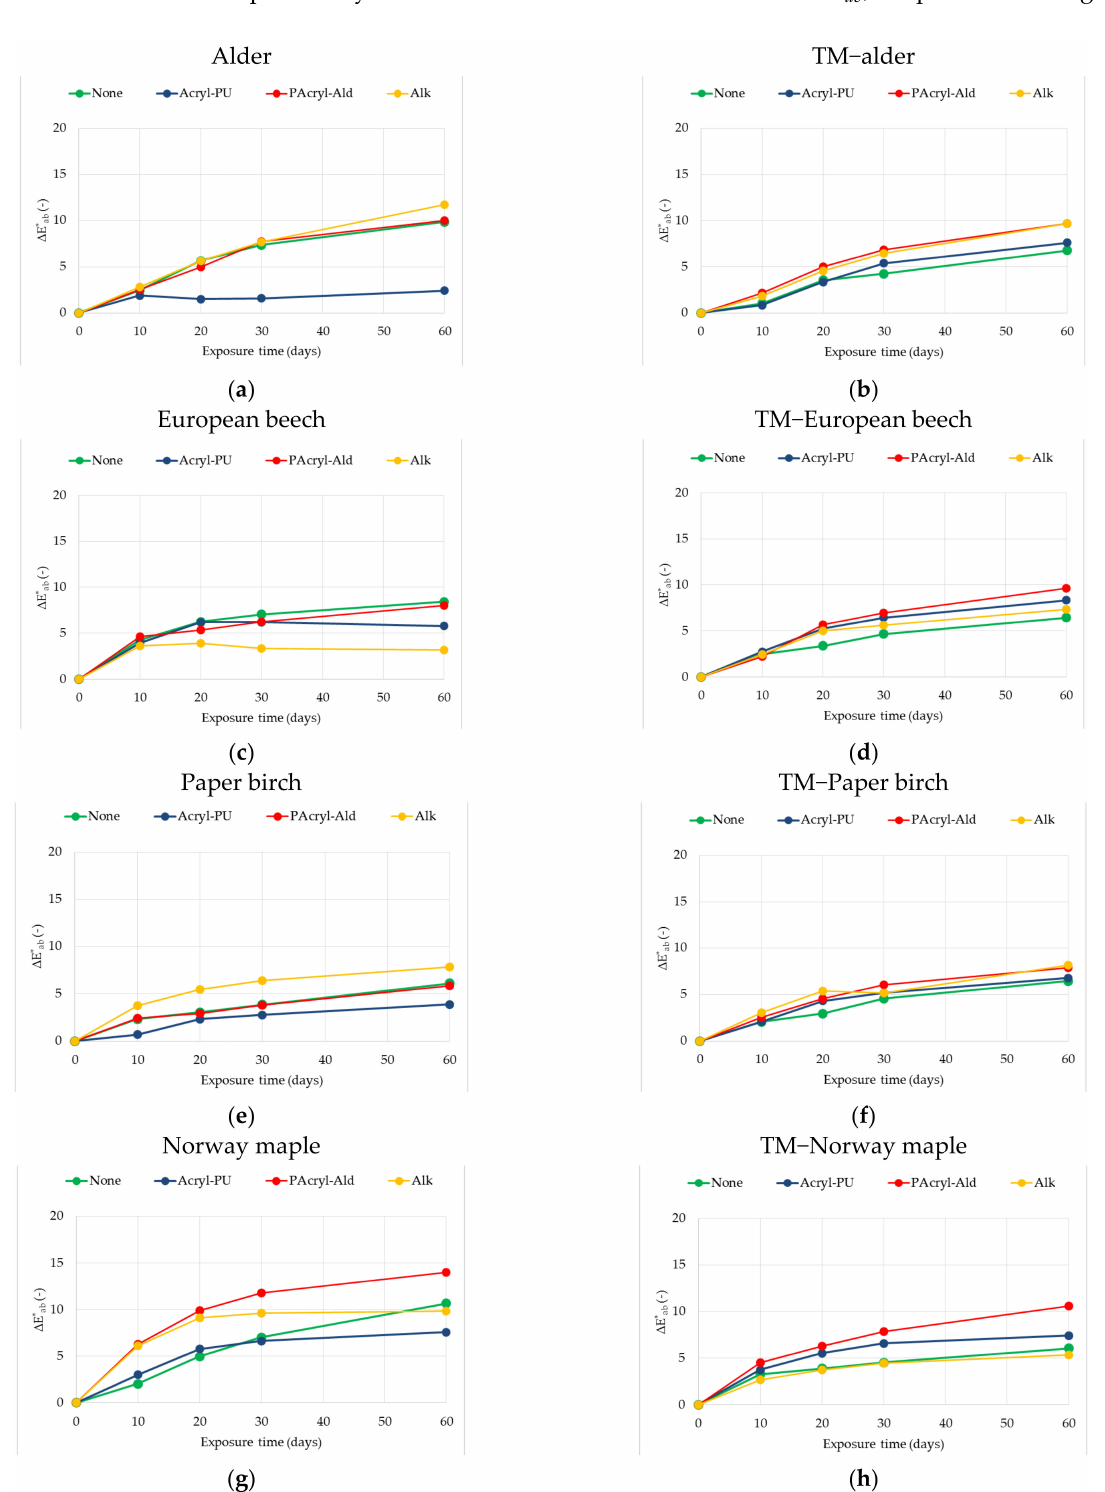
Figure 7. Variation in total colour difference ∆ E* ab after the exposure to indoor sunlight of coated and uncoated native ( a , c , e , g ), and thermally treated ( b , d , f , h ), wood for 60